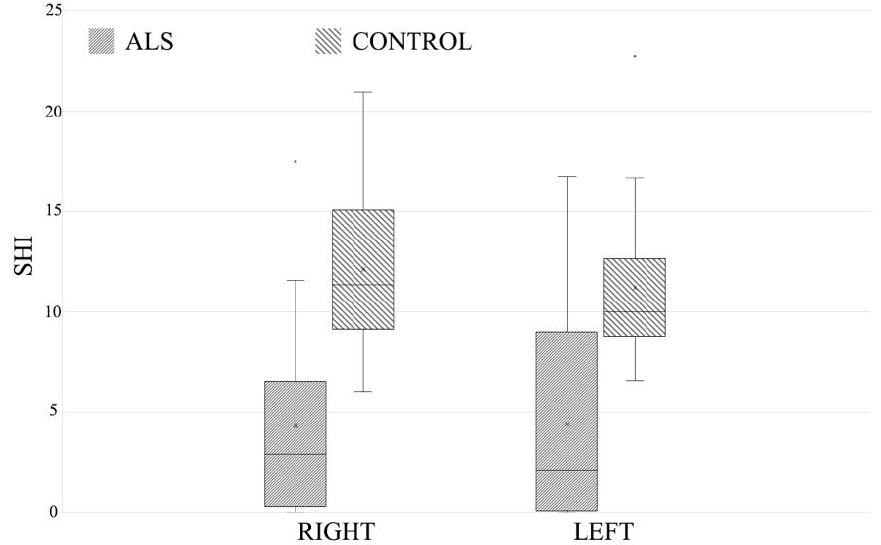
Figure 1. Distribution of the SHI values in the two study groups.